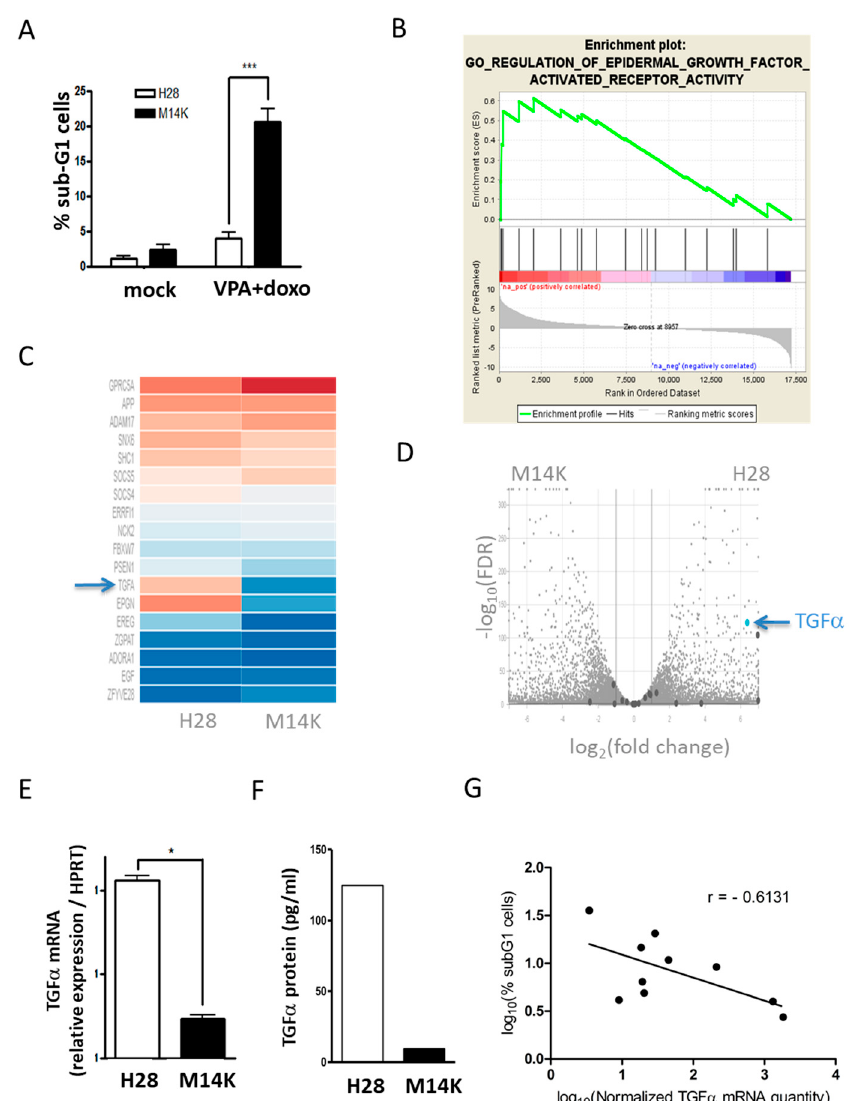
Figure 1. The sensitivity of mesothelioma (MPM) cells to valproic acid (VPA)-doxorubicin chemotherapy negatively correlates with expression of TGF α . ( A ) H28 and M14K mesothelioma cells were treated for 24 h with VPA (2 mM) and doxorubicin (100 nM). Apoptotic DNA fragmentation was evaluated by flow cytometry after ethanol fixation and propidium iodide labeling. Data (% of sub-G1 cells) are means ± standard deviations (SD) of three independent experiments. p -value < 0.001 (***) was obtained by the independent Student’s t test. ( B ) RNA sequencing of H28 and M14K cells. Enrichment plot of epidermal growth factor activated receptor (EGFR) activity gene set determined by gene set enrichment analysis (GSEA). ( C ) Hierarchical heat map of genes belonging to GO regulation of EGFR activity gene set. ( D ) Volcano plot based on log2 (fold change) and − log10 (false discovery rate, FDR). ( E ) The difference in TGF α transcription was confirmed by RT-qPCR in H28 and M14K cells. The HPRT housekeeping gene was used as an endogenous control in order to normalize TGF α expression. RT-qPCR data are represented as means ± SD, and statistical significance was calculated using the Mann-Whitney U test (* p -value < 0.05). ( F ) Quantification of TGF α protein by ELISA. ( G ) A correlation test (Pearson) was performed between the log10-transformed data of normalized TGF α expression and the levels of apoptosis induced by VPA-doxorubicin in 10 mesothelioma cell lines (M14K, M38K, MSTO-211H, NCI-H2452, H28, SPC111, SPC212, ZL34, ZL5 and ZL55). Apoptosis was measured by quantifying the proportion of sub-G1 cells by flow cytometry. The results are means of three independent experiments, and the Pearson correlation coefficient (r) is represented on the graph ( p -value = 0.0594).